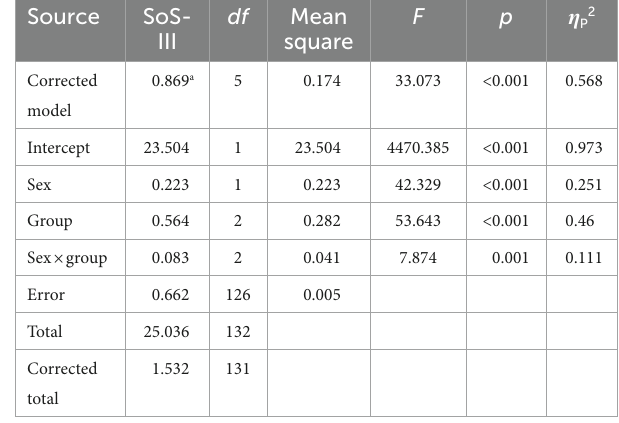
TABLE 1 Univariate analysis of variance (UNIANOVA) results for between- subjects